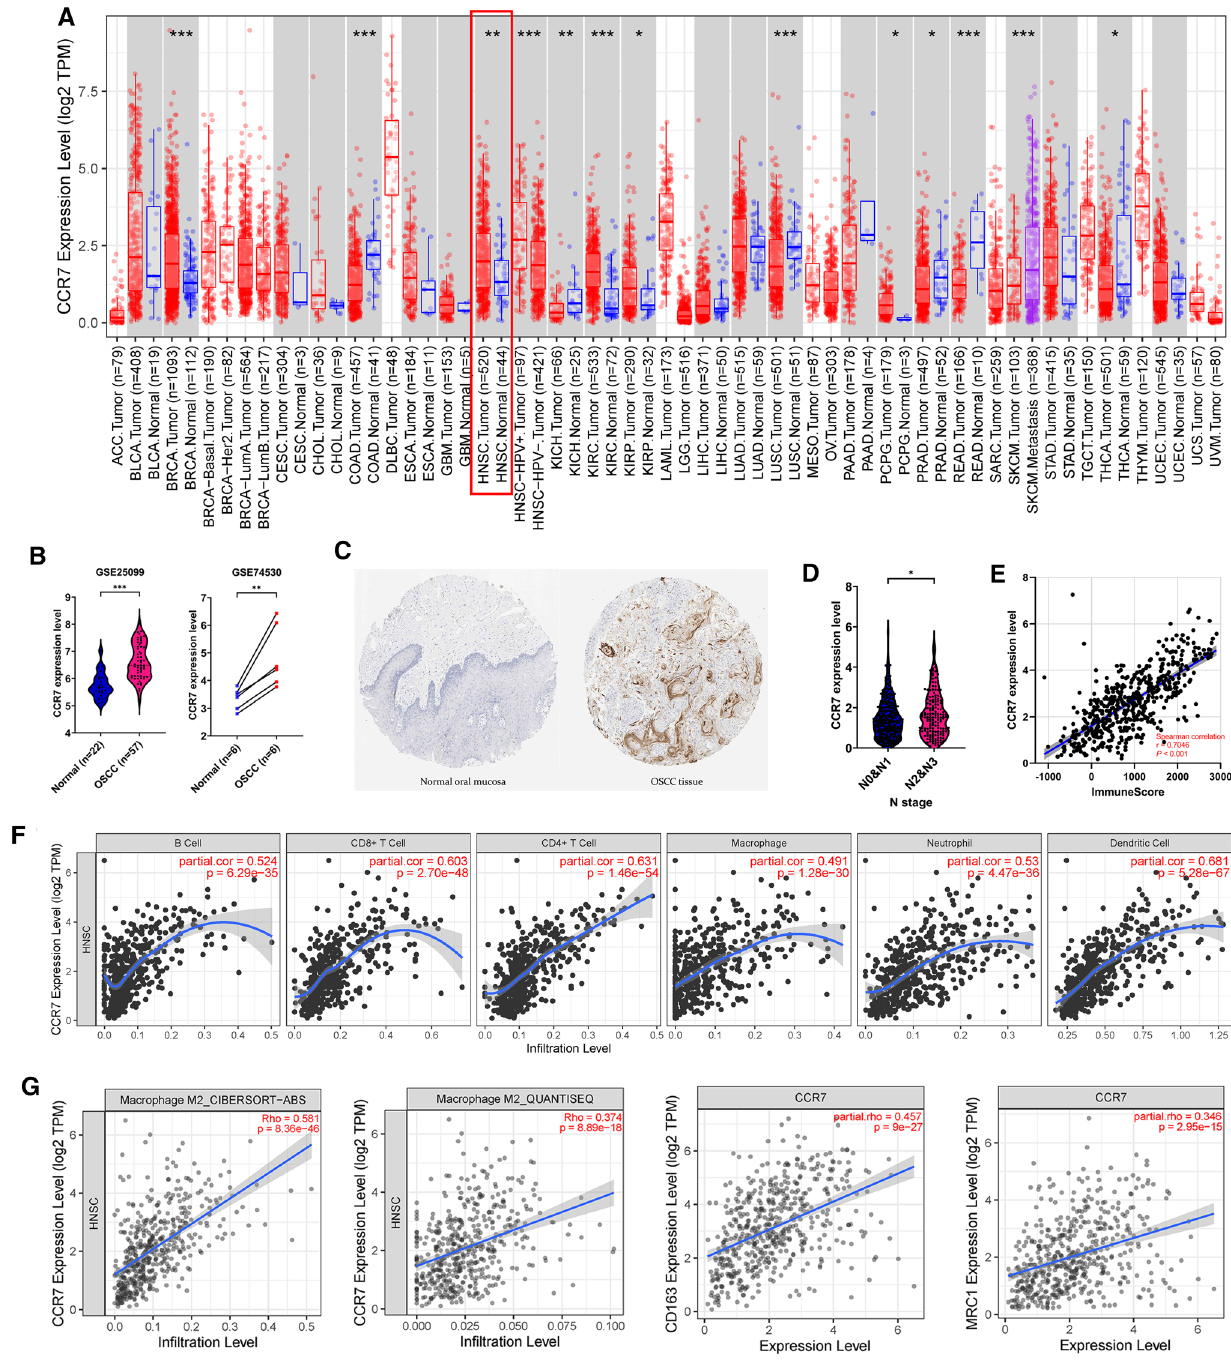
Fig. 1 CCR7 is overexpressed and positively correlated with M2 macrophage infiltration in OSCC patients. A CCR7 expression patterns across different tumour types in TIMER2.0. The red box represents HNSCC tissues and adjacent normal tissues. B CCR7 expression levels in OSCC tis- sues and normal oral tissues in GSE25099 and GSE74530 dataset. C CCR7 protein expression levels in OSCC tissues and normal oral epithelial tissues, determined by immunohistochemistry staining from HPA website. magnification, × 4. D Relationship between CCR7 expression and N stage of HNSCC patients, based on TCGA. E The association between CCR7 expression and the Immunescore of TCGA-HNSCC patients gen- erated by ESTIMATE algorithm. F Correlation between CCR7 expression level and immune infiltration levels in TCGA-HNSCC patients based on TIMER2.0 database. G Correlation between CCR7 expression and M2 macrophage in TCGA-HNSCC patients, based on TIMER2.0 database. * P < 0.05, ** P < 0.01, *** P <